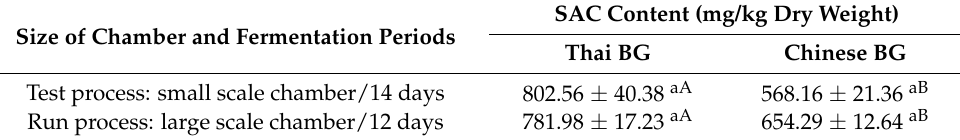
Table 3. The SAC content of Thai BG, and Chinese BG in different fermentation chamber and different time of thermal process in test process (14 days) and run process (12 days) of fermentation periods at 70 ◦ C, 80% RH. Size of Chamber and Fermentation Periods